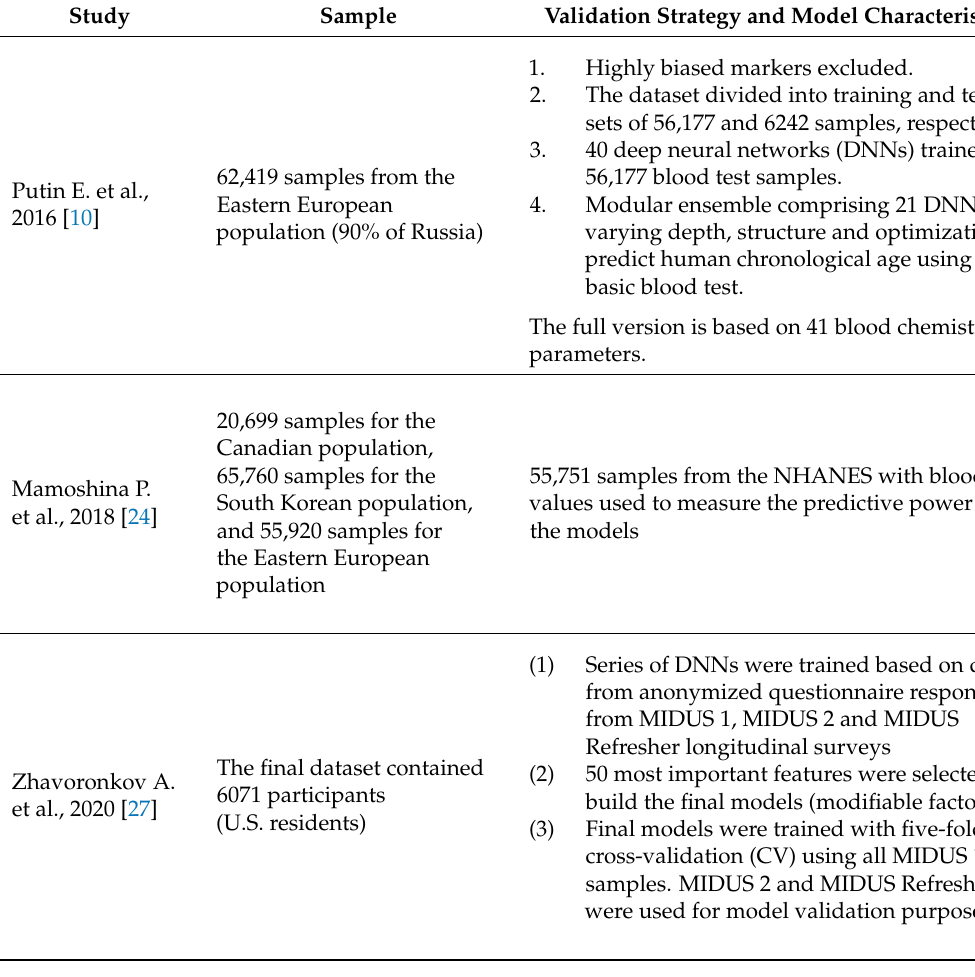
Table 1. Main characteristics of the blood biochemistry-based and psychological status-based